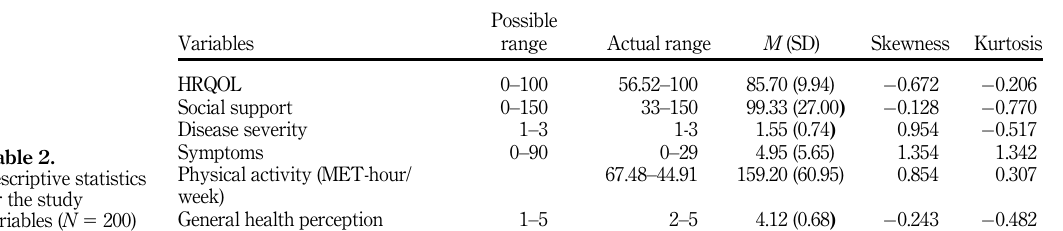
for the study variables ( N 5 200)